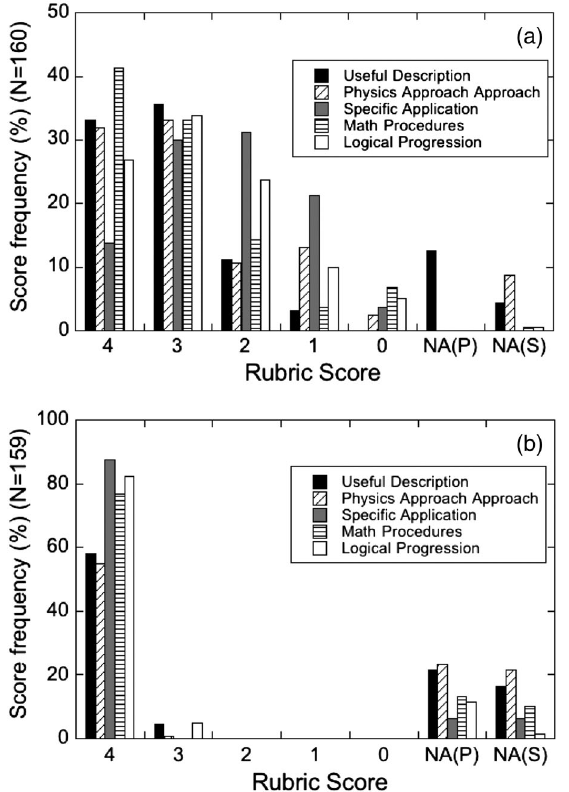
FIG. 6. Rubric scores from (a) 160 student solutions and (b) 159 solutions written by an instructor or taken from a textbook solution manual. This rubric was identical to the final rubric but used a maximum score of